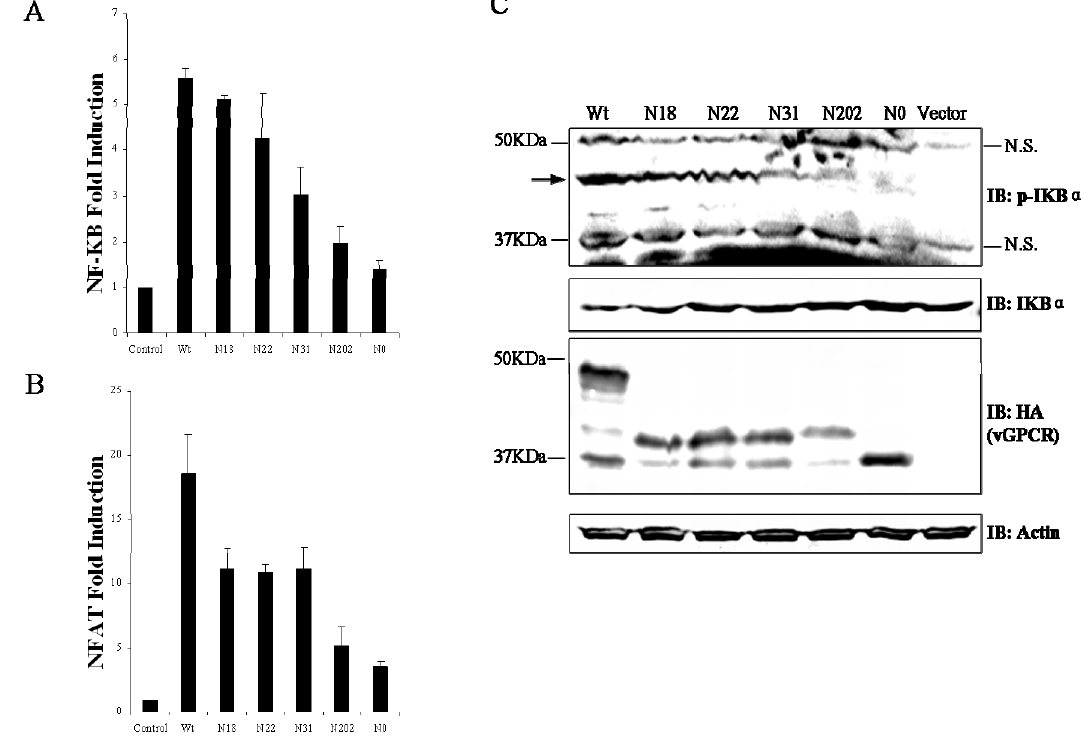
Figure 3. Glycosylation is necessary for vGPCR-mediated signaling. ( A ) and ( B ). Glycosylation is necessary for the induction of NFAT and NF- κ B by vGPCR. HEK293T cells were co-transfected with Luci-NF- κ B or Luci-NFAT, B-Gal reporter construct, and plasmids expressing vGPCR or vGPCR glycosylation mutants. Transfected cells were harvested and whole cell lysates were used for reporter assay according to the methods. ( A ) NF- κ B fold induction by vGPCR and its glycosylation mutants. ( B ) NFAT fold induction by vGPCR and its glycosylation mutants. Data represent the average value of three independent experiments and error bars represent standard deviation. ( C ). Glycosylation is necessary for vGPCR triggered phosphorylation of I- κ B. HEK293T cells were transfected with plasmids expressing vGPCR or vGPCR glycosylation mutants separately, Transfected cells were harvested at 24 h post transfection and whole cell lysates were examined by western blot to detect the I κ B α phosphorylation. p-I κ B α : phospho-I κ B α ; N.S.: non-specific band; Wt: FRT-TO-HA-vGPCR; Vector: FRT-TO empty vector; N18, N22, N31, N202, N0: FRT-TO plasmids expressing corresponding vGPCR mutants with HA tag; the arrow indicates the phosphorylated I κ B α